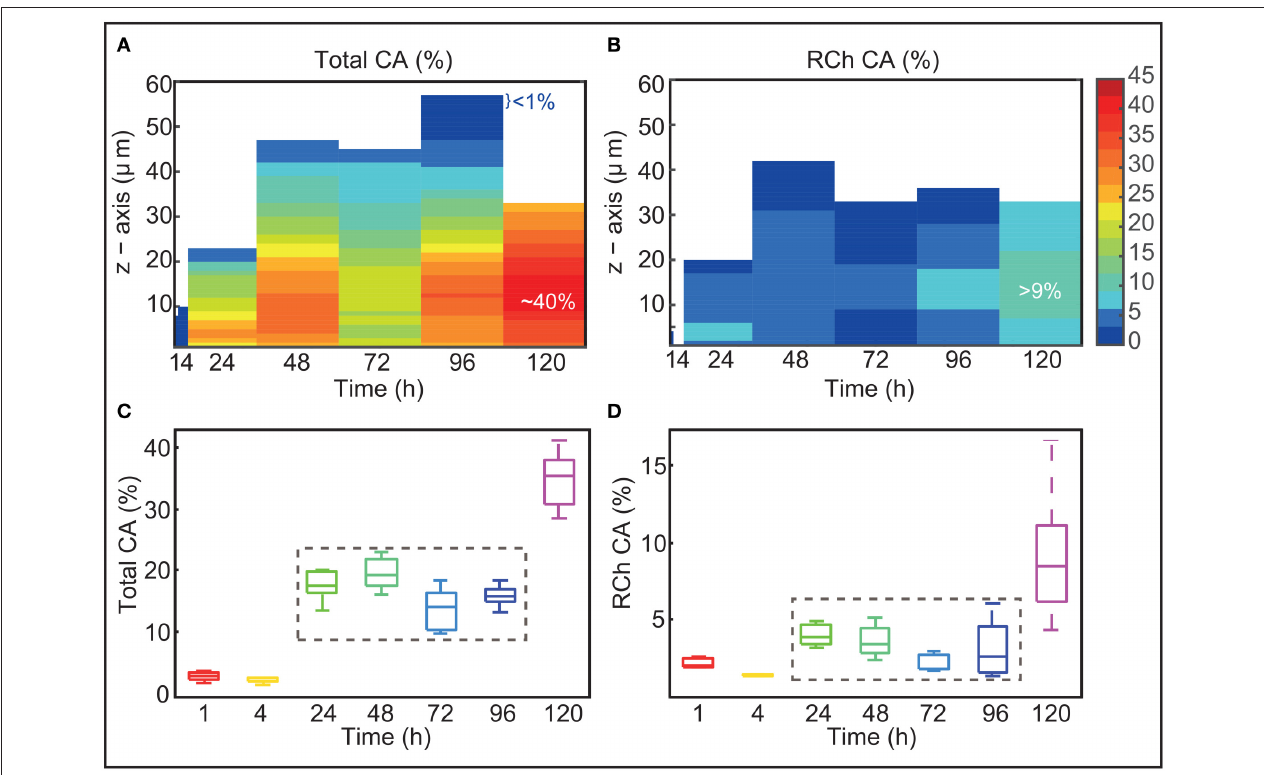
FIGURE 3 | Covered area vs biofilm thickness and time. (A,B) Present the mean CA values obtained over experimental replicates as functions of time and thickness ( z -axis). The Figures show that biofilms are structured in layers of different CA values. Maximum CA is around 40 % . At 120 h damaged or dead cells account for almost half of the area covered by the biofilm. (C,D) Present the mean CA values over all slices as a function of time for the different replicates. Box plots provide information on the variability among the different replicates. CA values are kept almost constant from 24 to 96 h. At 120 h CA increases substantially.